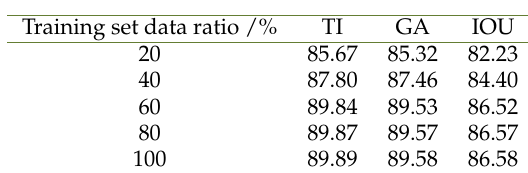
Table 1. Detection accuracy.